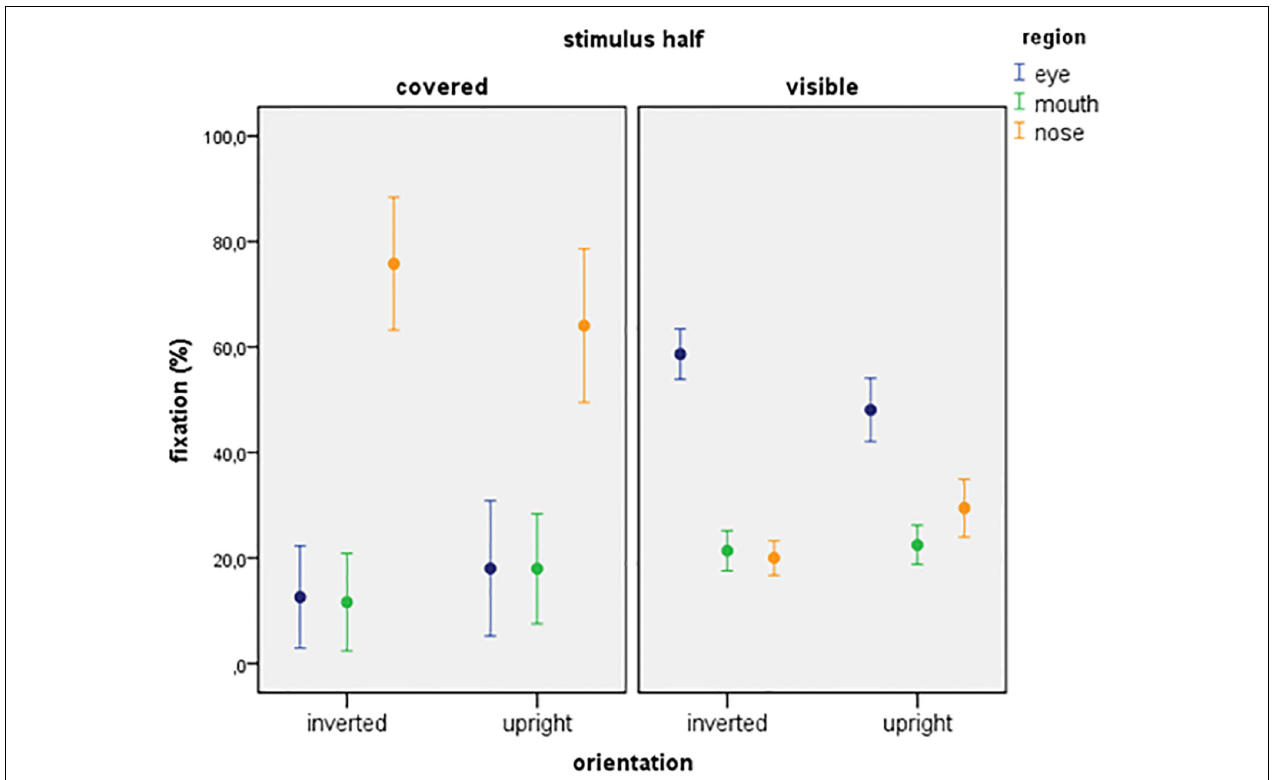
FIGURE 3 | Relative fixation values targeted at the three regions on the covered and the visible side of the